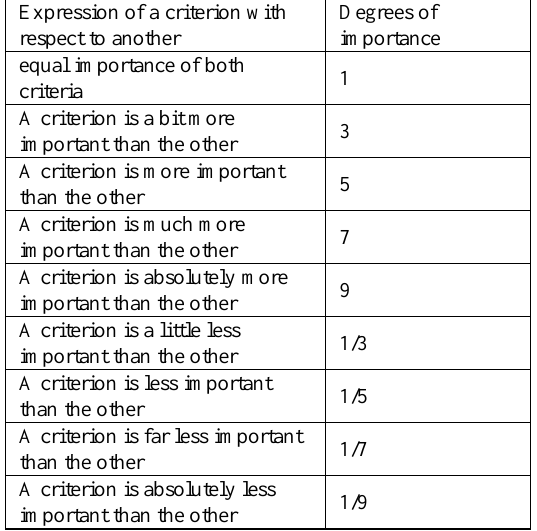
Table 1. Digital Scale Saaty pairwise comparison